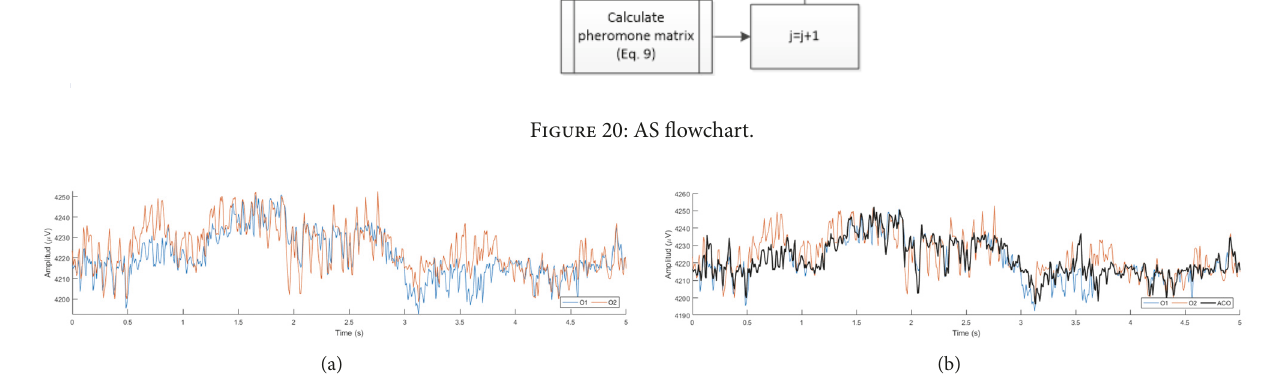
Figure 21: (a) EEG signals of the electrodes O1 and O2 and (b) representation of the signal optimized by means of the ACO algorithm based on the signals of the electrodes O1 and